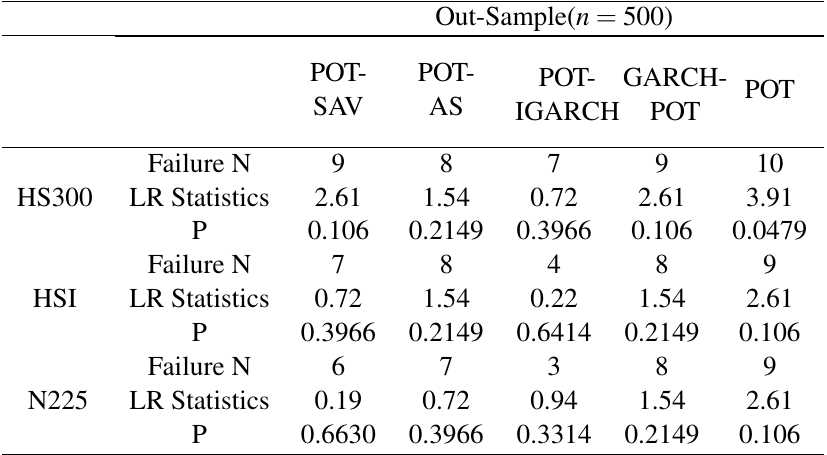
Table 5 Extreme quantile 1% VaR posteriori test